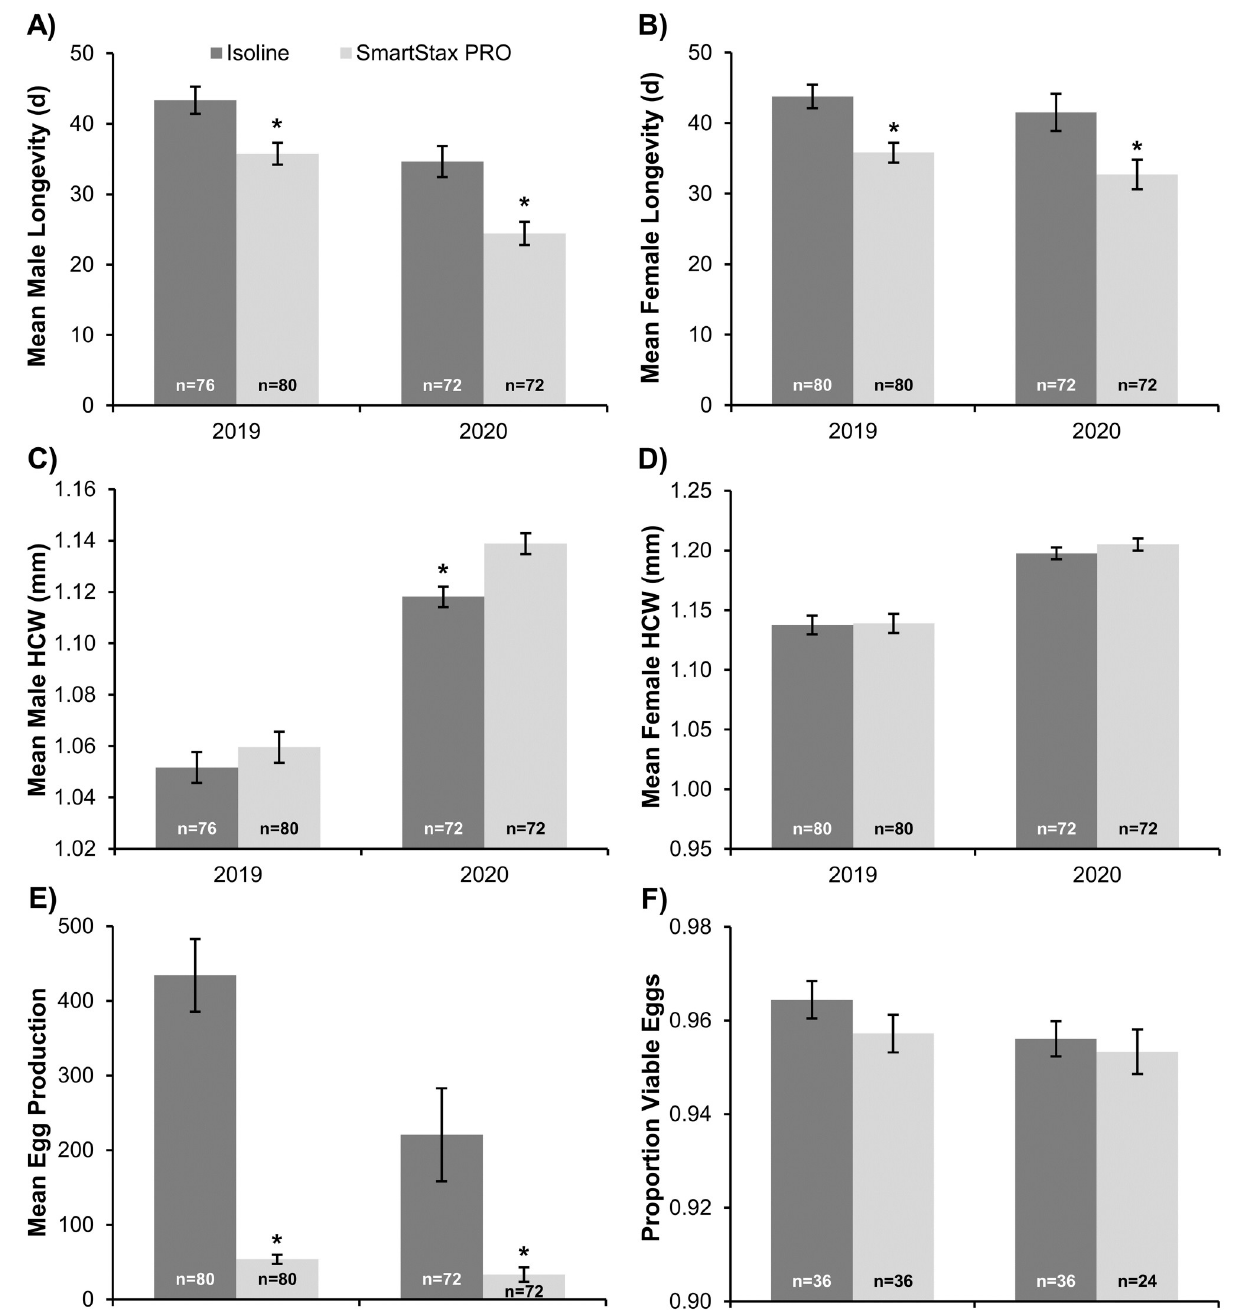
Fig 3. Life history parameters characterized during adult dietary exposure experiments in 2019 and 2020. A) Mean male longevity (days, d), B) Mean female longevity (days, d), C) Mean male head capsule width (HCW; mm), D) Mean female head capsule width (HCW; mm), E) Mean egg production per female, and F) Proportion of viable F 1 eggs. Data from 2019 and 2020 experiments were analyzed separately. Individual bars represent the mean ± standard error and include the number of male/female pairs (n) established for each adult diet treatment. An asterisk indicates significant differences between adult diet treatments within years ( P <